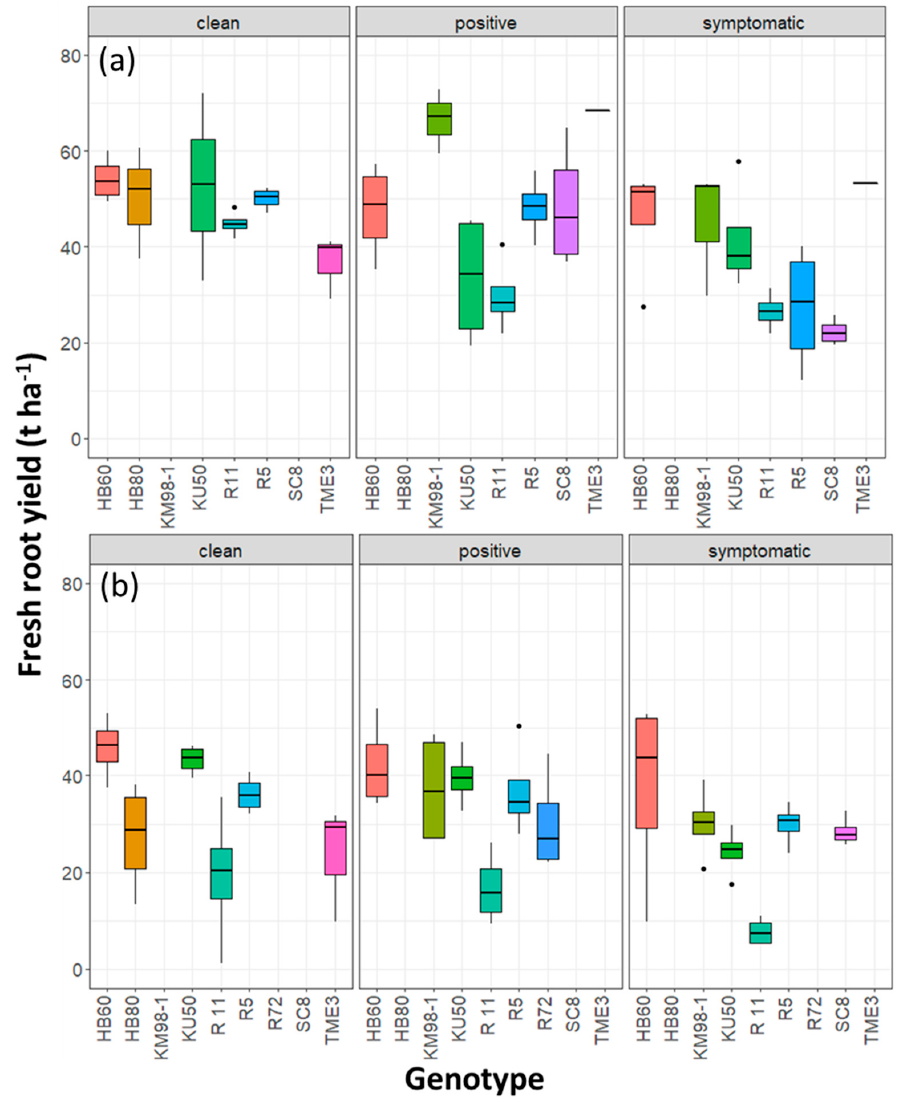
Figure 3. Fresh root yield (t ha − 1 ) of cassava varieties planted using disease-free stakes (clean), positive selected stakes from diseased fields (positive selection) and stakes selected from